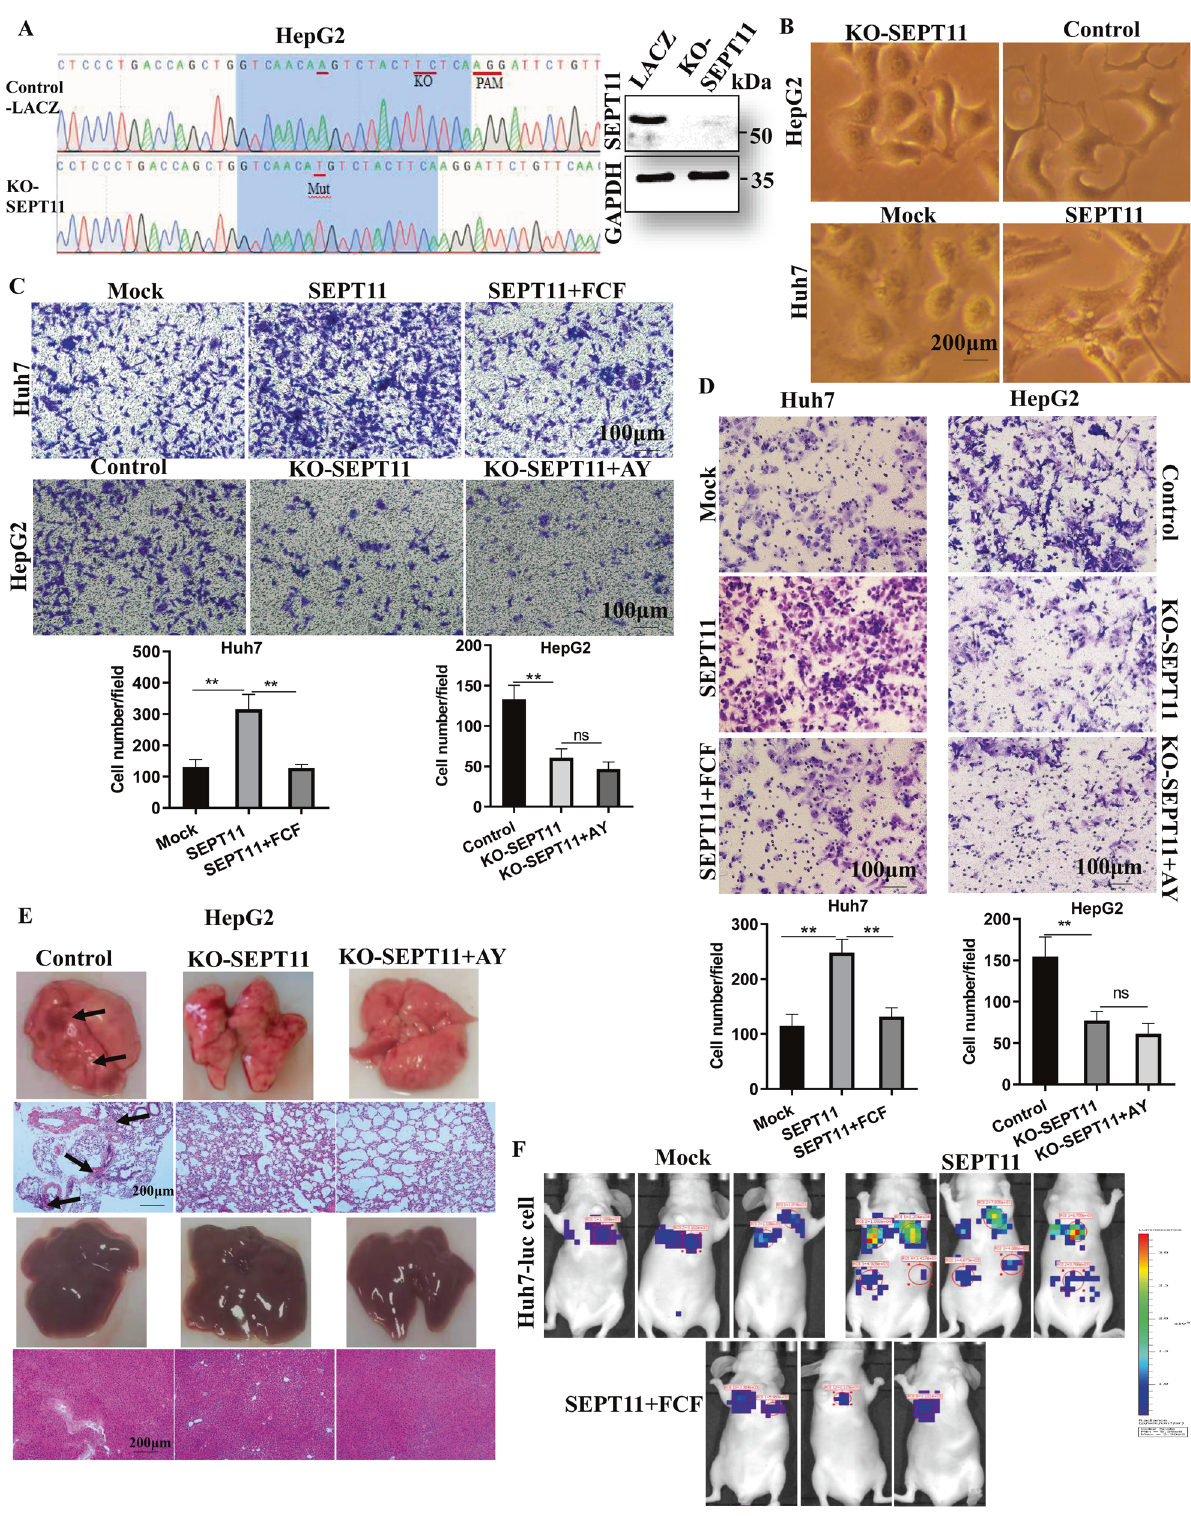
Fig. 3 Functions of SEPT11 in HCC were analyzed by experiments in vitro and vivo. A Sequencing and WB to verify CRISPR/Cas9-mediated gene knockout of SEPT11 cell line; B Observation of the effect of SEPT11 on cell morphology; C Detection of the effect of SEPT11 on cell migration ability; D Transwell detected the effect of SEPT11 on cell invasion ability; E HepG2 cells were injected into the tail vein, the liver and lungs of the mice were taken for observation and photography on the 28th day, and the tissues were fi xed for HE staining, the arrows indicate location of tumor focus; F Huh7-luciferase cells were injected into the tail vein of nude mice, observed and photographed using the mouse in vivo fl uorescence imaging system on the 28th day.